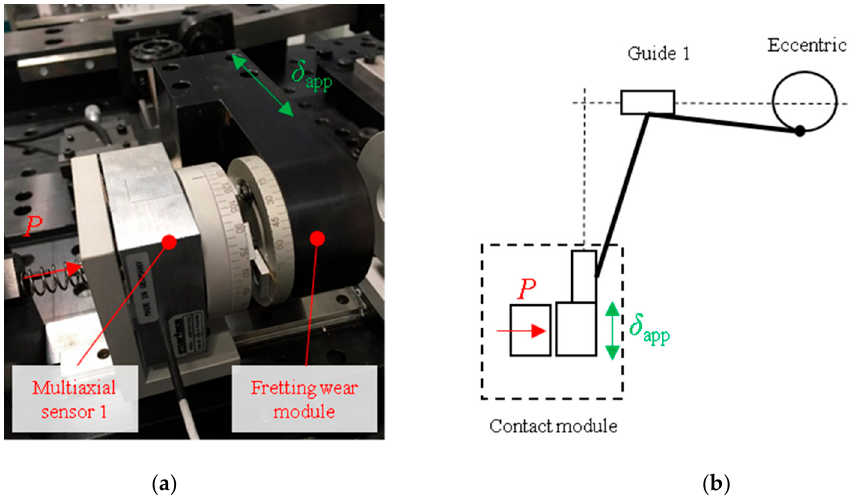
Figure 2. Fretting wear test apparatus: ( a ) Fretting wear contact module; ( b ) Schematic view of the fretting wear test configuration. Reproduced with permission of MDPI [15].